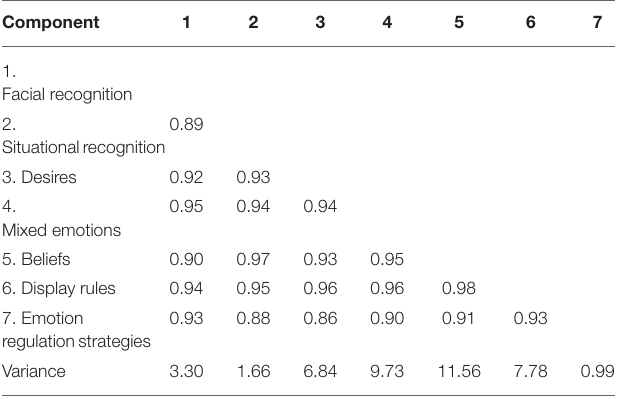
TABLE 4 | Latent intercorrelations and variances of the ATEM 3–9 components.